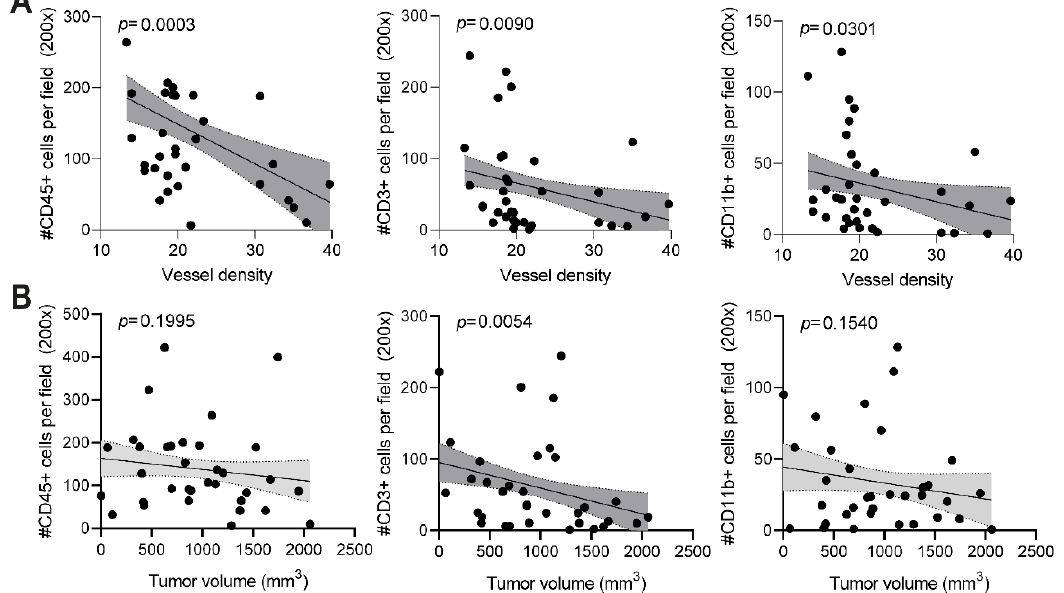
Figure 5. Enhanced immune cell infiltration correlates with vessel density and tumor growth ( A ) Significant correlation between the number of CD45+, CD3+, and CD11b+ immune cells and vessel density (number of CD31+ vessel per microscopic field). ( B ) Correlation between CD45+, CD3+, and CD11b+ immune cell infiltration and final tumor volume at day 14 (mm 3 ). Significant correlations ( p < 0.05) are indicated with the dark grey area.